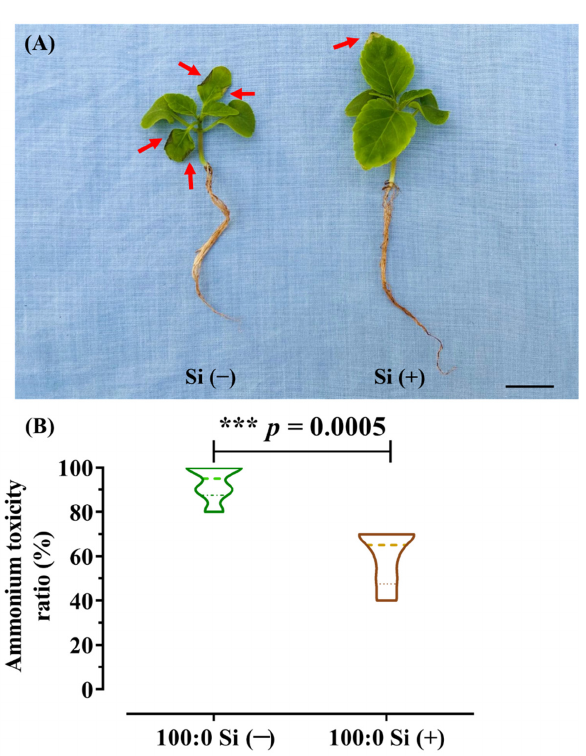
Figure 2. ( A ) Plant growth status and ( B ) NH 4+ toxicity appearance ratio (%) in response to 100:0 NH 4 + :NO 3 − nutrient solution supplemented with or without Si. Data displayed is the mean ± standard deviation (SD) of n = 6 replicates. Statistical significances (*** p < 0.001) between Si ( − ) and Si (+) were determined using a two-tailed Student’s t -test. Red arrows point to the typical NH 4+ toxicity symptoms in foliage. Scale bar refers to 2 cm.